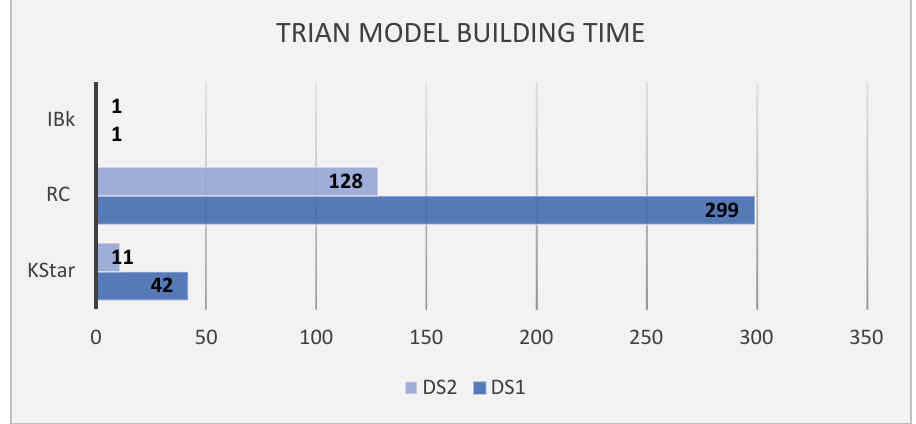
Figure 17. Time Required to Build a Model for each Classifier.